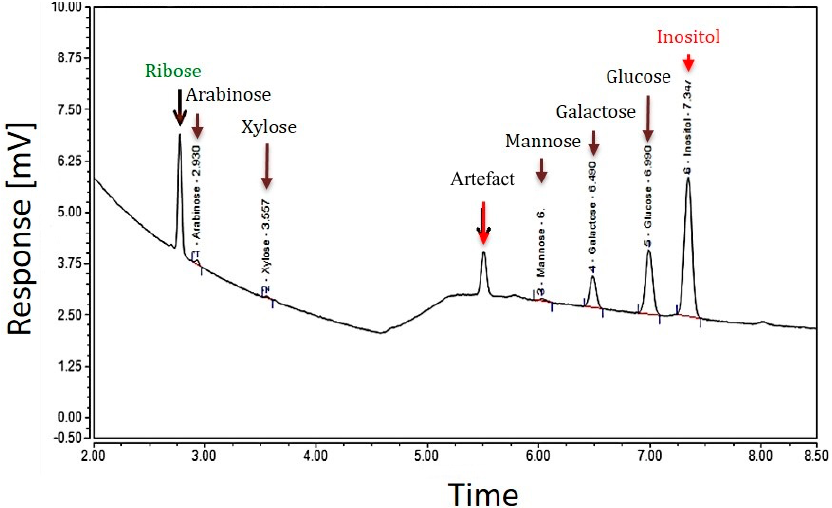
Figure 2. GC profile of the EPS of R. tataouinensis TTB310 which were pre-treated by acid hydrolysis (13 M H 2 SO 4 ): The major peaks detected correspond to the monosaccharides: ribose, glucose, and galactose, and the minor peaks are those of xylose, arabinose, mannose. The internal standard was inositol.